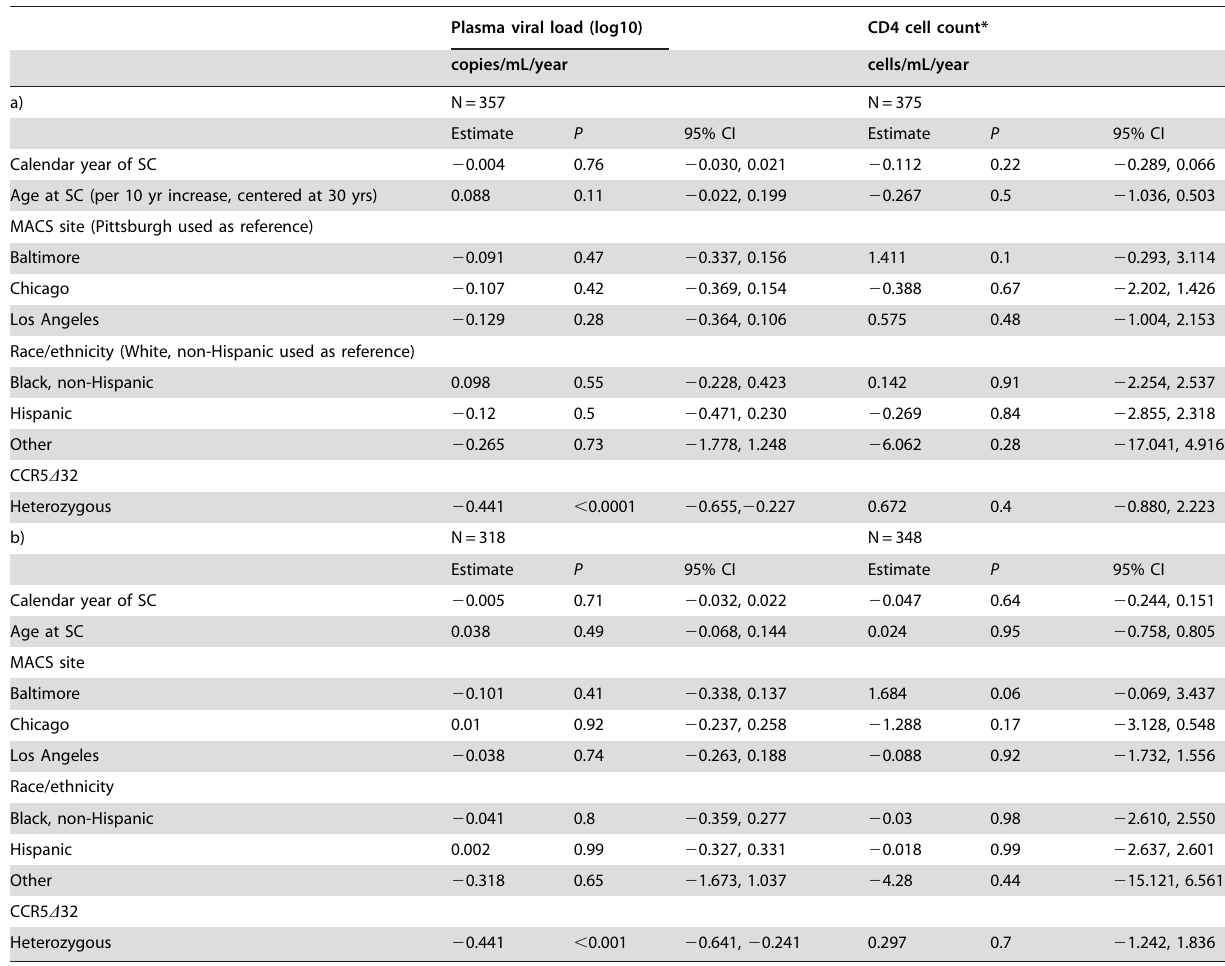
Table 2. Multivariate analyses of prognostic markers of HIV-1 disease. .. ... .... ... ... .... ... ... .... ... ... .... ... ... .... ... ... .... ... ... .... ... ... .... ... ... .... ... ... .... ... ... .... ... ... .... ... ... .... ... ... .... ... ...